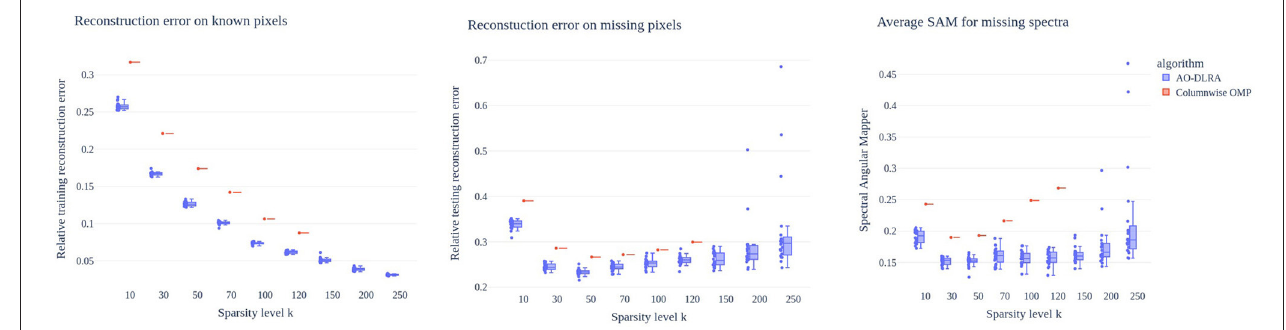
FIGURE 3 | Performance of DMF (blue) vs. Columnwise OMP (red, single valued box) for inpainting a patch of the Urban HSI with missing pixels at various sparsity levels. Twenty random initializations are used for